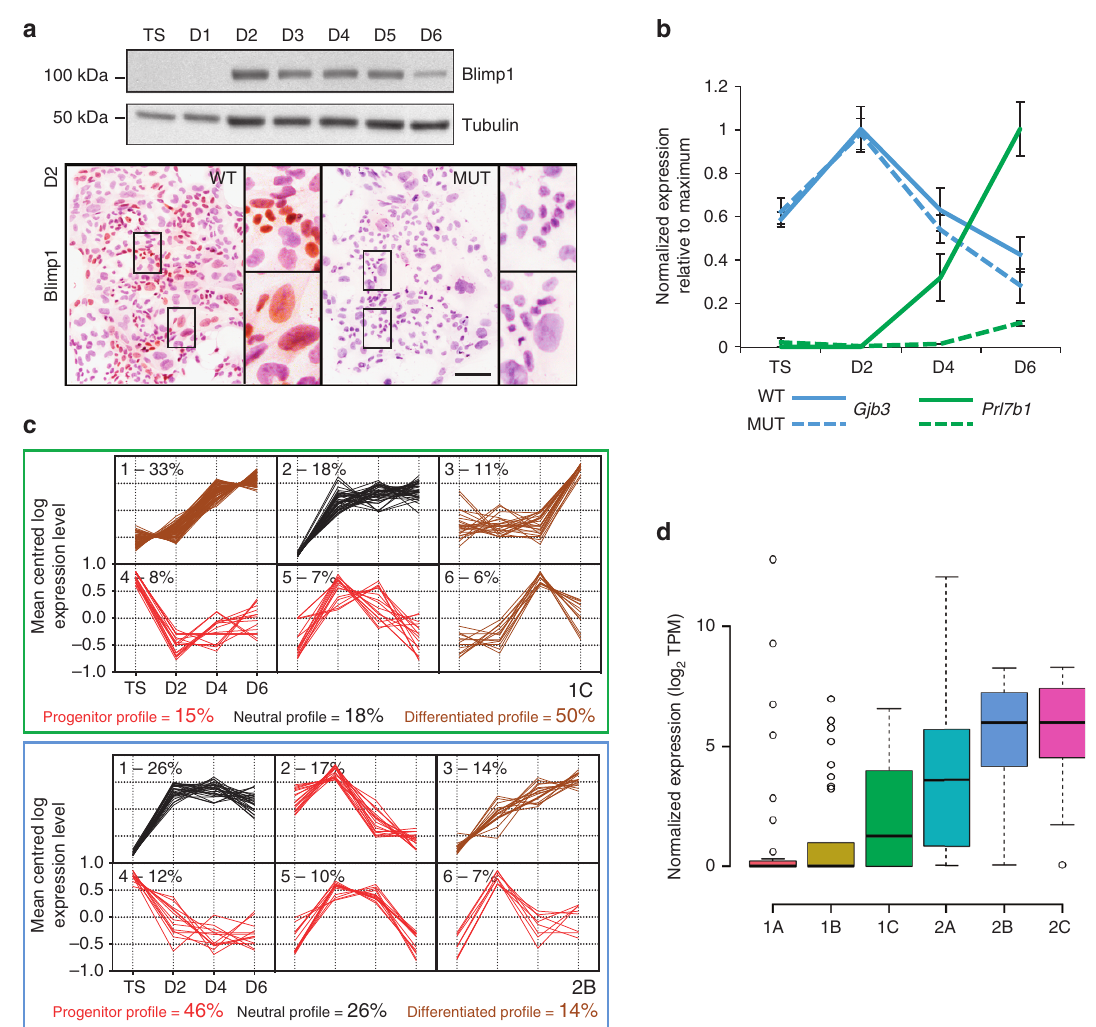
Figure 4 | scRNA-seq data together with transcriptional profile changes during in vitro TS cell differentiation implicates Gjb3 þ group 2B cells as trophoblast progenitors. ( a ) The appearance of Prdm1 /Blimp1 þ diploid cells beginning at around day 2 during in vitro differentiation. Bar, 100 m m. ( b ) Gjb3 is transiently upregulated early in TS cell differentiation, whilst the SpA-TGC marker Prl7b1 is induced at late stages during wild type but not Prdm1 mutant differentiation. Data represents mean ± SEM of 6–10 samples per genotype at each stage ( c ) k-means clustering of genes defining SpA-TGCs (1C) and progenitor trophoblasts (2B). The six largest clusters per sub-group. Clusters are categorized as displaying a progenitor profile—containing genes either highest in TS cells or transiently upregulated in early differentiation; a differentiated profile—genes highest in later differentiation; or a neutral profile— genes upregulated early on exit from the TS state and remaining high throughout differentiation. Percentages of genes corresponding to progenitor, neutral or differentiated profiles are indicated. ( d ) scRNA-seq median expression per group of cell cycle-regulated genes. Boxed region, bar and whiskers represent interquartile range, median and 95% central range of the data. Outliers indicated by open